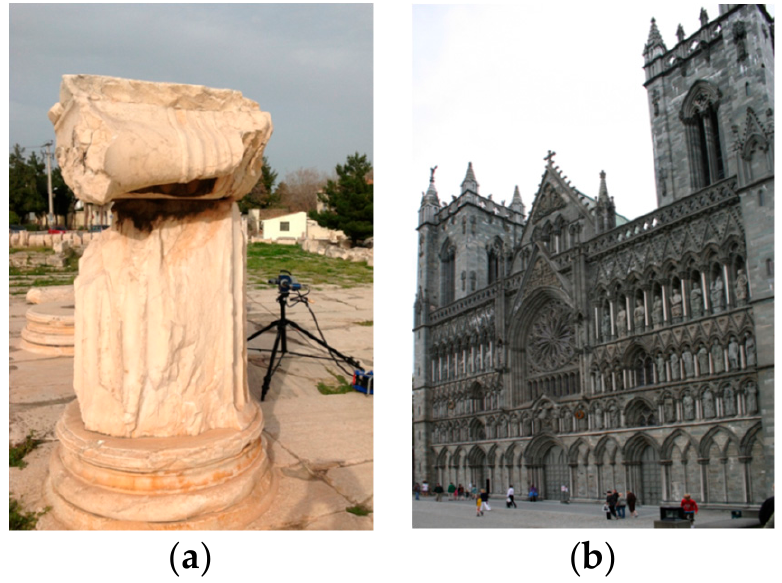
Figure 13. The two CH monuments considered for study: ( a ) The Sanctuary of Demeter and ( b ) Nidaros Cathedral in Trondheim, Norway.